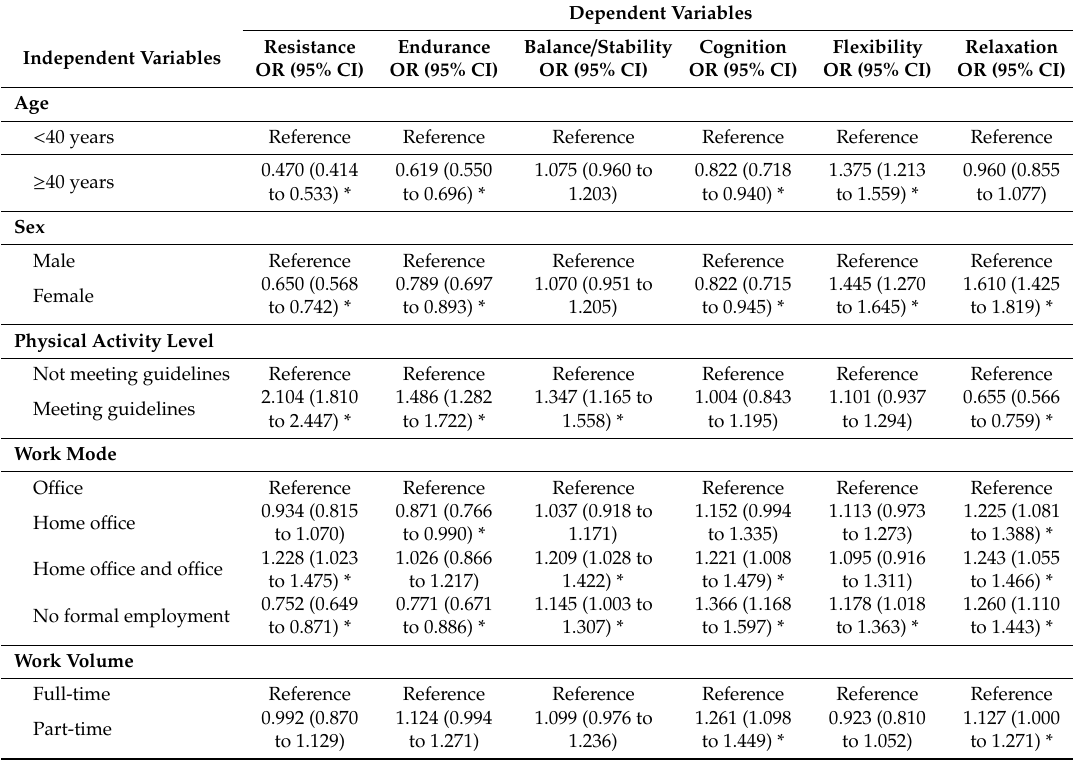
Table 2. Associations between preferred workout contents and sample